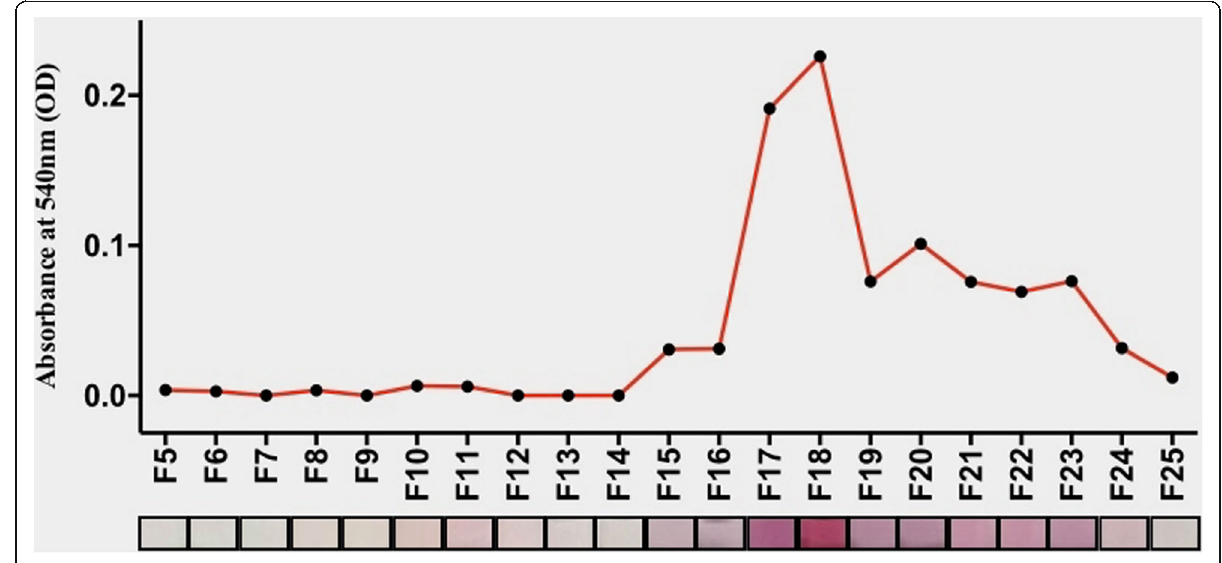
Fig. 5 GNP synthesis from day 10 Fruc-Hb fractions. The colorimetric profile of GNPs synthesised from day 10 fractions and their absorption maxima plotted against the fraction